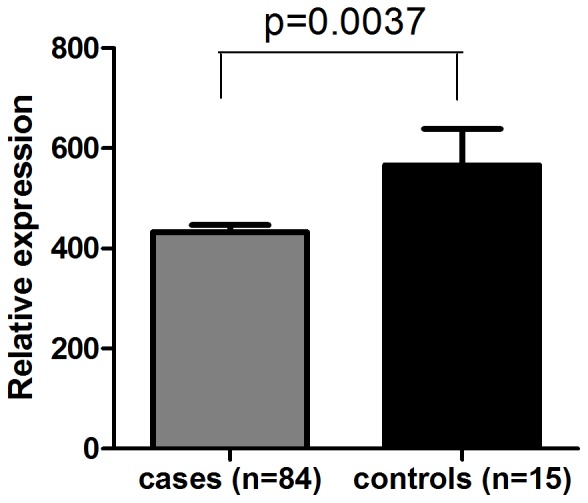
Relative ARLTS1 RNA expression from PCa patients and healthy controls.Relative ARLTS1 RNA expression was determined by RNA sequencing analysis. Columns represent means of individuals; bars represent SD.